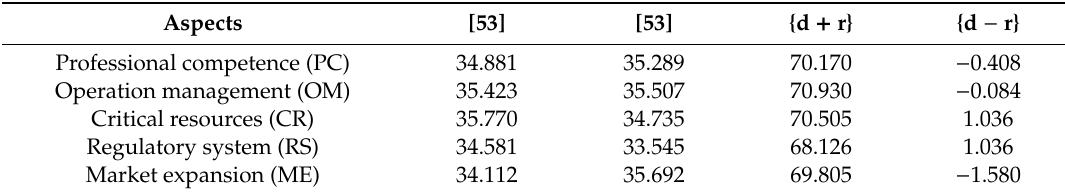
Table 9. The degree of full